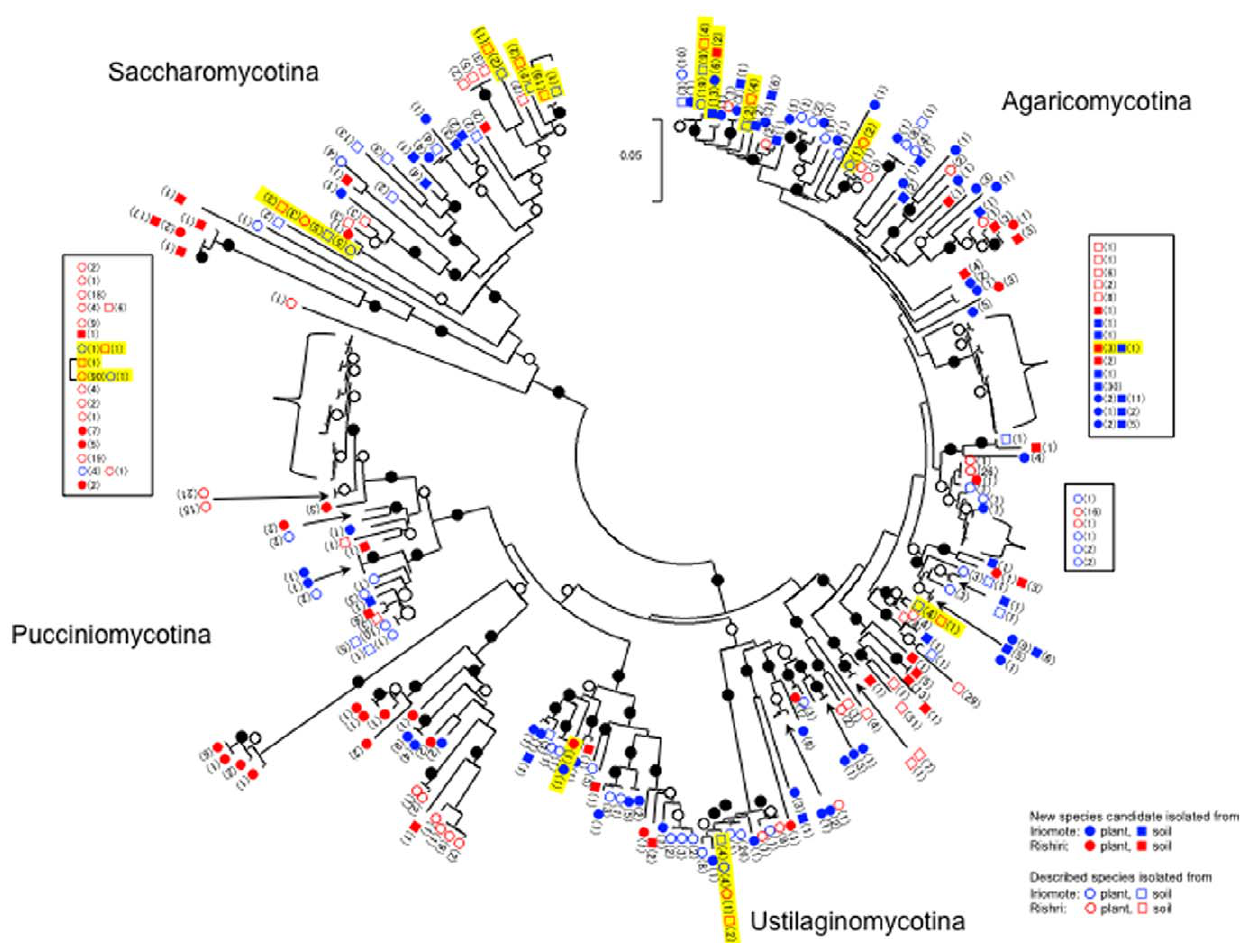
Figure 1. A neighbor-joining tree of isolates based on the D1/2 region unique sequences. The evolutionary distance (refer to the bar) was calculated according to Kimura [26]. Bootstrap values [27] were summarized by black dots (indicating at least 90% support) or by black rings (indicating at least 60% support). Blue solid ring, new species candidate isolated from a plant of Iriomote Island; blue open ring, described species isolated from a plant of Iriomote; blue solid square, new species candidate isolated from soil of Iriomote; blue open square, described species isolated from soil of Iriomote; blue solid ring, new species candidate isolated from a plant of Rishiri Island; red open ring, described species isolated from a plant of Rishiri; red solid square, new species candidate isolated from soil of Rishiri; red open square, described species isolated from soil of Rishiri. Numerals in brackets after ring or square indicate the number of isolates. Yellow color on OTUs indicates this species was isolated from both islands.